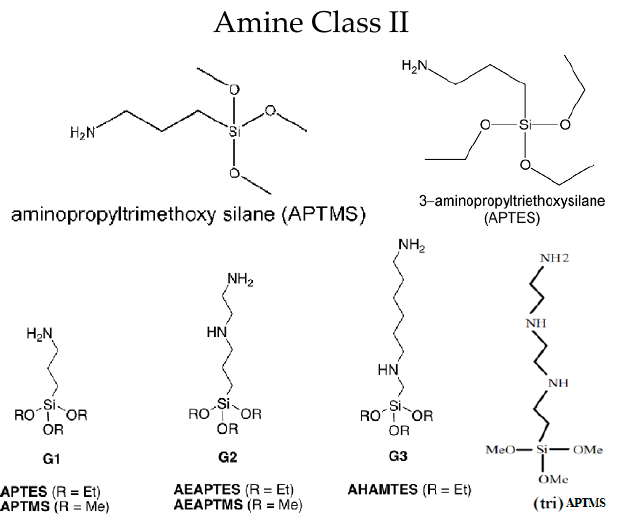
Figure 5. Common amines used for aerogels applied for CO 2 capture.